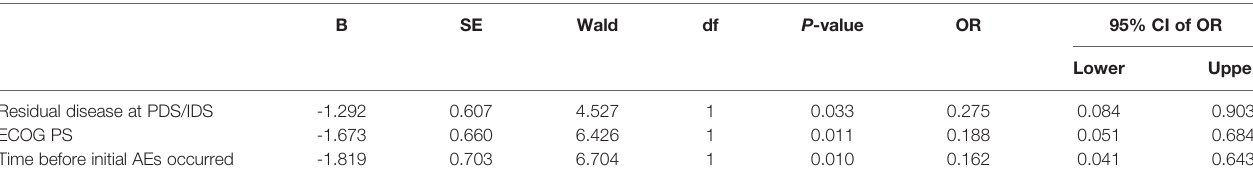
TABLE 2 | Logistic regression analysis (Forward: LR) of multi-factor for predicting disease control